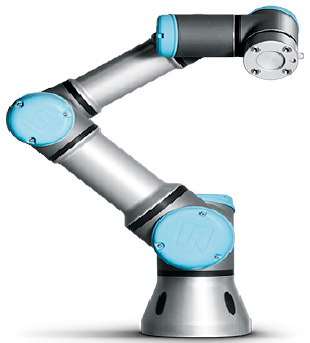
Figure 2. The real UR3 manipulator.